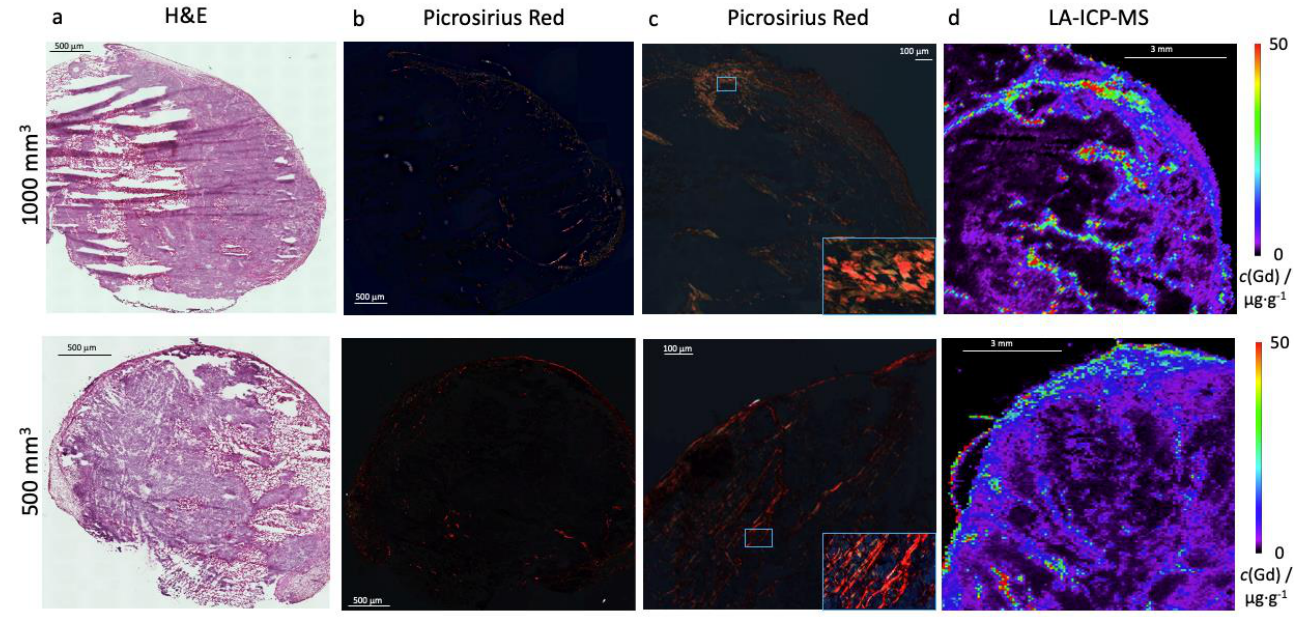
Figure 3. Ex vivo analysis of collagen in 1000 mm 3 and 500 mm 3 tumors. ( a ) shows a H&E stain in 1000 mm 3 tumor ( top ) and 500 mm 3 ( bottom ). ( b ) shows Picrosirius red staining of collagen of the complete tumor section with a polarization filter in 1000 mm 3 tumor ( top ) and 500 mm 3 ( bottom ) and ( c ) shows a representative magnification area. ( d ) LA-ICP MS was performed to localize Gadolinium in the tumor sample. The scale shows the concentration of c(Gd)/µg∙g −1 .